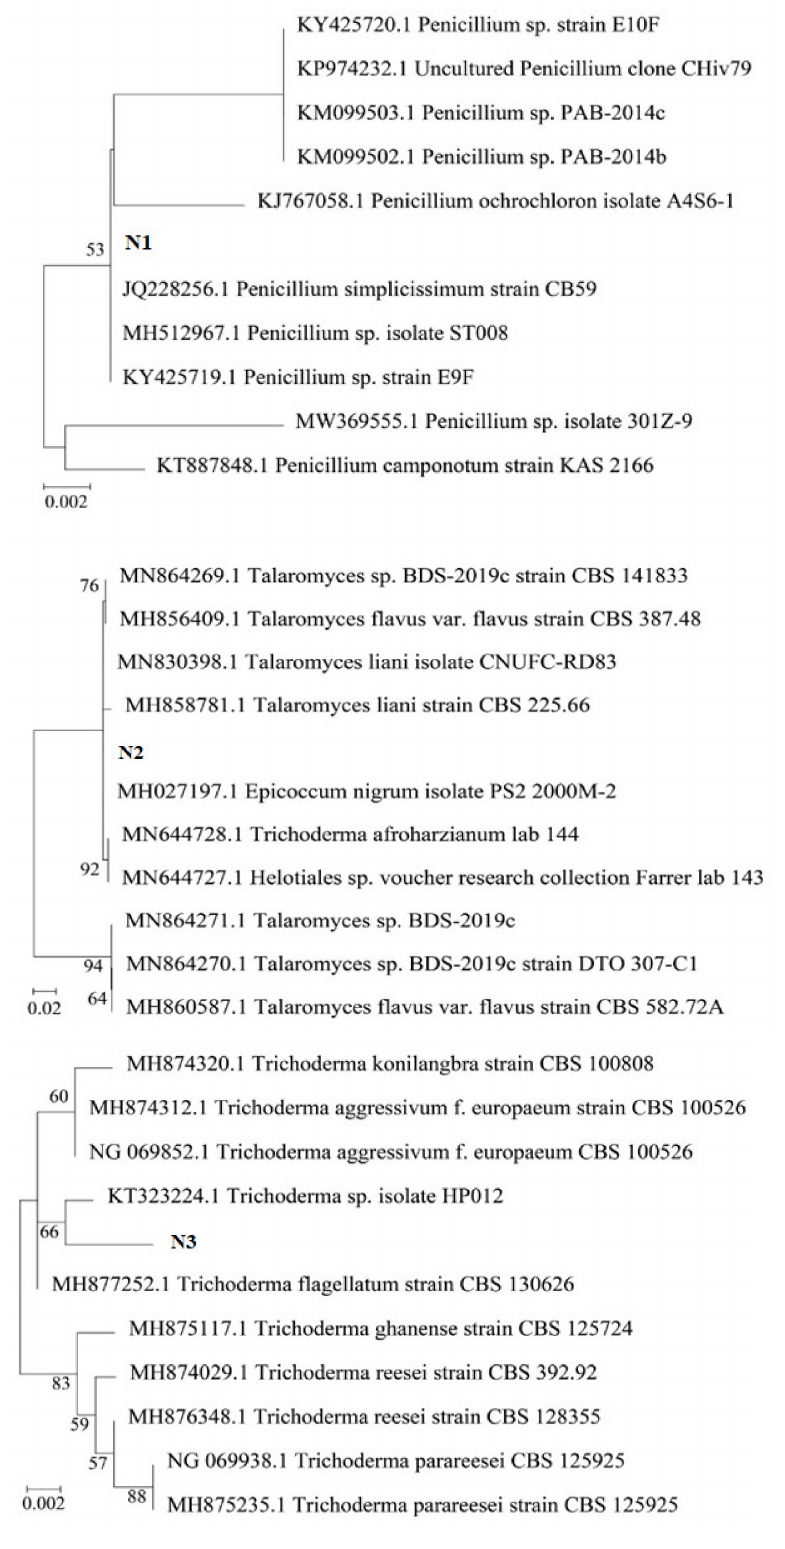
Figure 1. Phylogenetic tree of three fungal strains: Penicillium simplicissimum CN7 , Talaromyces flavus BC1 , and Trichoderma konilangbra DL3